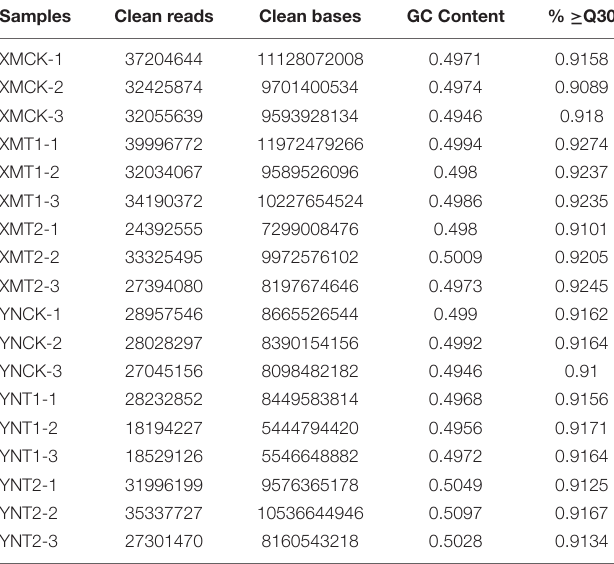
TABLE 2 | Statistical table of RNA-seq data.